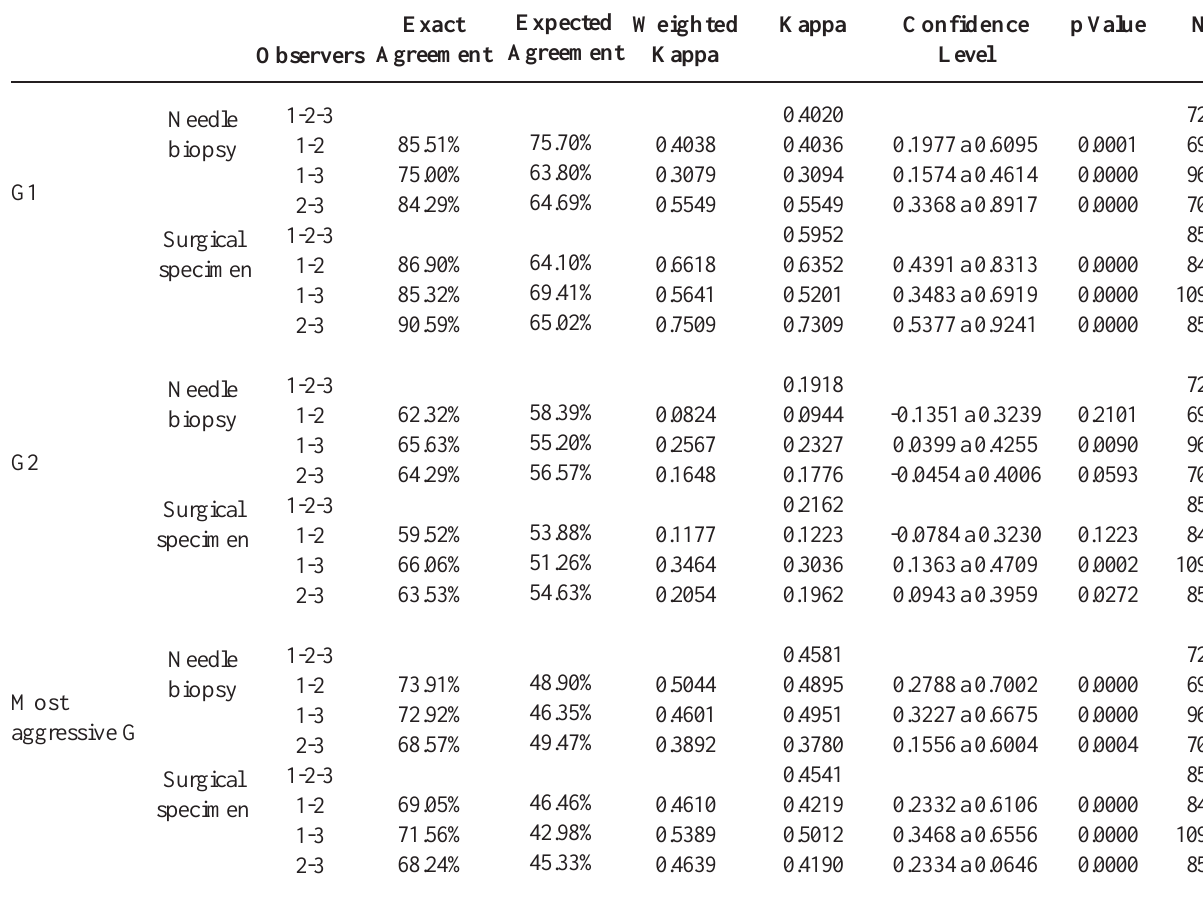
Table 2 – Interobserver agreement as regards primary, secondary and the most aggressive Gleason grade in needle biopsies and surgical specimens, considering each patient as an independent